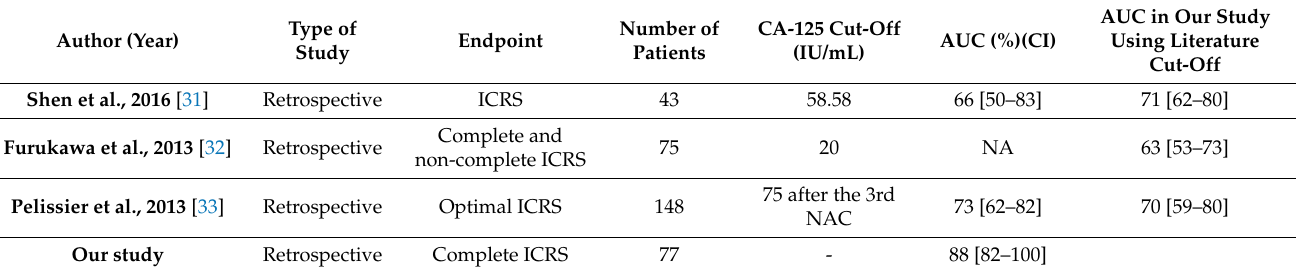
Table 2. Literature review of preoperative CA-125 levels after NAC and prediction of opti- mal/complete cytoreductive surgery of